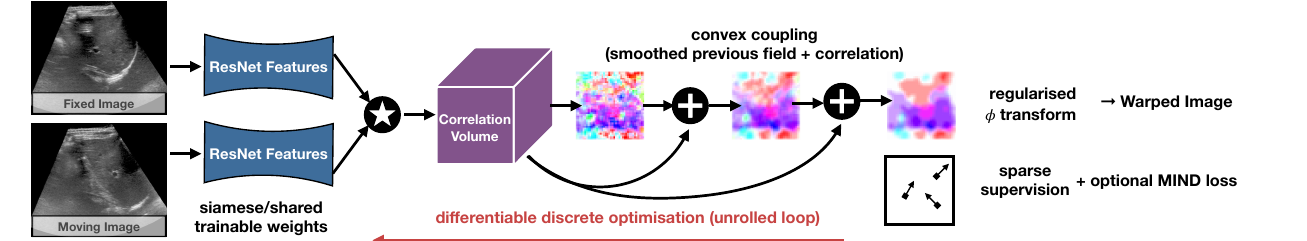
Figure 1. Concept of differentiable convex optimisation with ResNet feature backbone. The discrete correlation layer computes the dissimilarity across feature vectors of both images over a large search window in the moving scan. The optimum of the resulting correlation volume would yield a noisy deformation estimate that is smoothed. A coupling tensor that penalises deviations from the smooth estimate is added to the correlation in the following step yielding a refined smooth estimate. Through this intrinsic regularisation a very sparse supervision with 1–4 landmarks is sufficient.